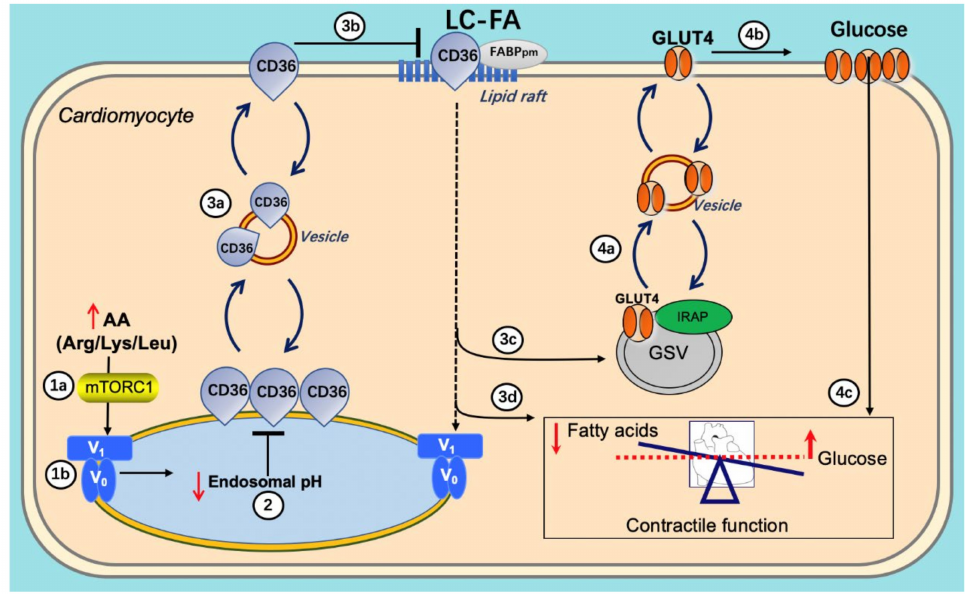
Figure 6. Schematic presentation of the re-assembly of v-ATPase as a target to restore contractile function in lipid-overloaded heart